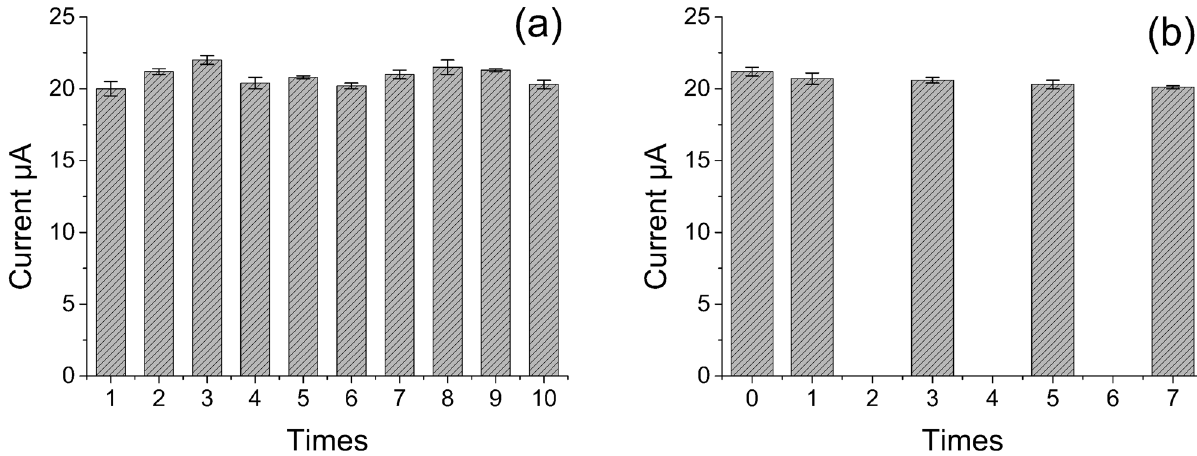
Figure 6: The ( a ) reproducibility and ( b ) storage stability of G/PTH/NG/GCE in the detection of ascorbic acid.